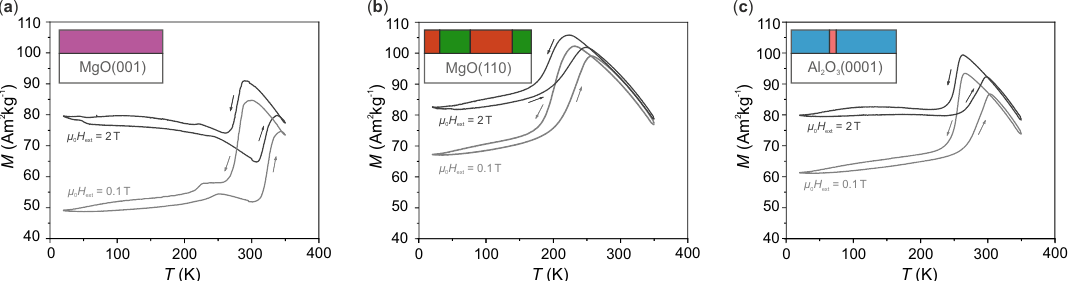
Figure 2. Magnetization measurements as function of temperature at a constant external magnetic field of µ 0 H ext = 0.1T and 2T: ( a ) Sample A on MgO(001), ( b ) sample B on MgO(110) and ( c ) sample C on Al 2 O 3 (0001). Arrows reflect the measurement directions. The sketches in the top left corner of each graph symbolize the microstructure of the films. The colours resemble those of the orientations in Figure